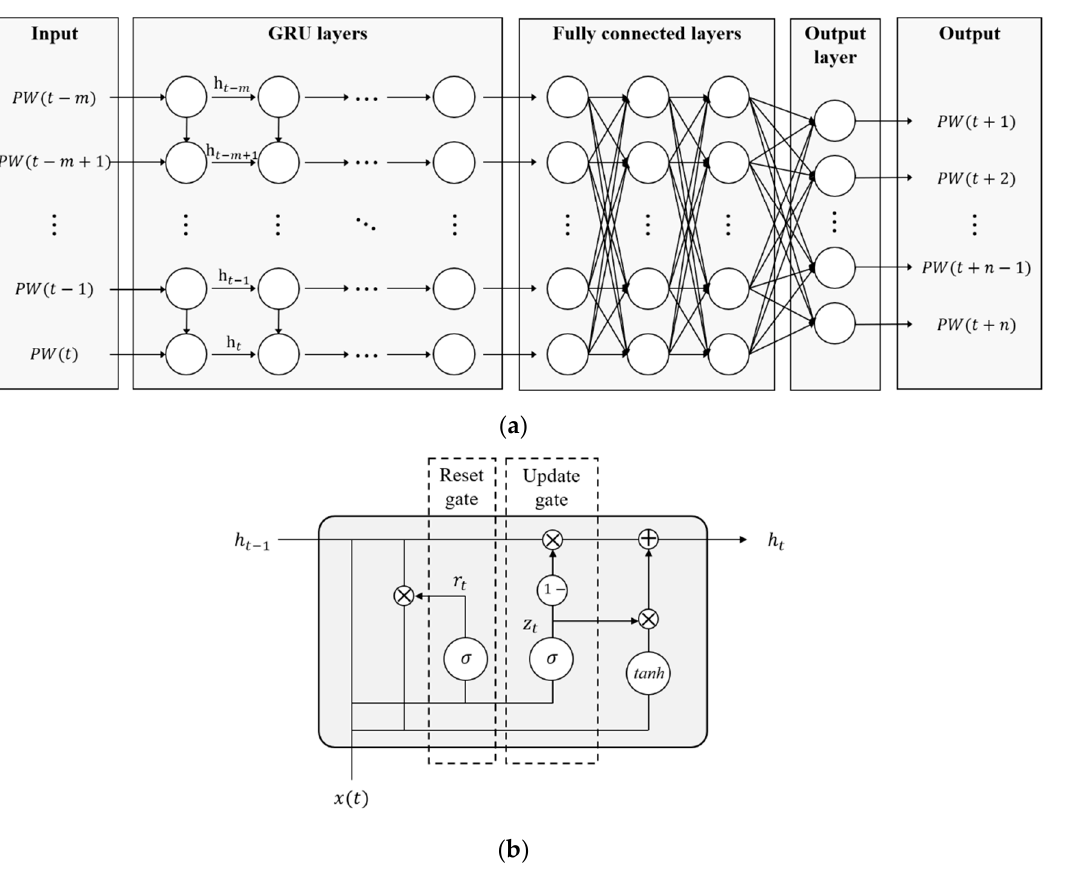
Figure 6. Prediction of local load demand and PV power production: ( a ) GRU network architecture; ( b ) GRU cell.